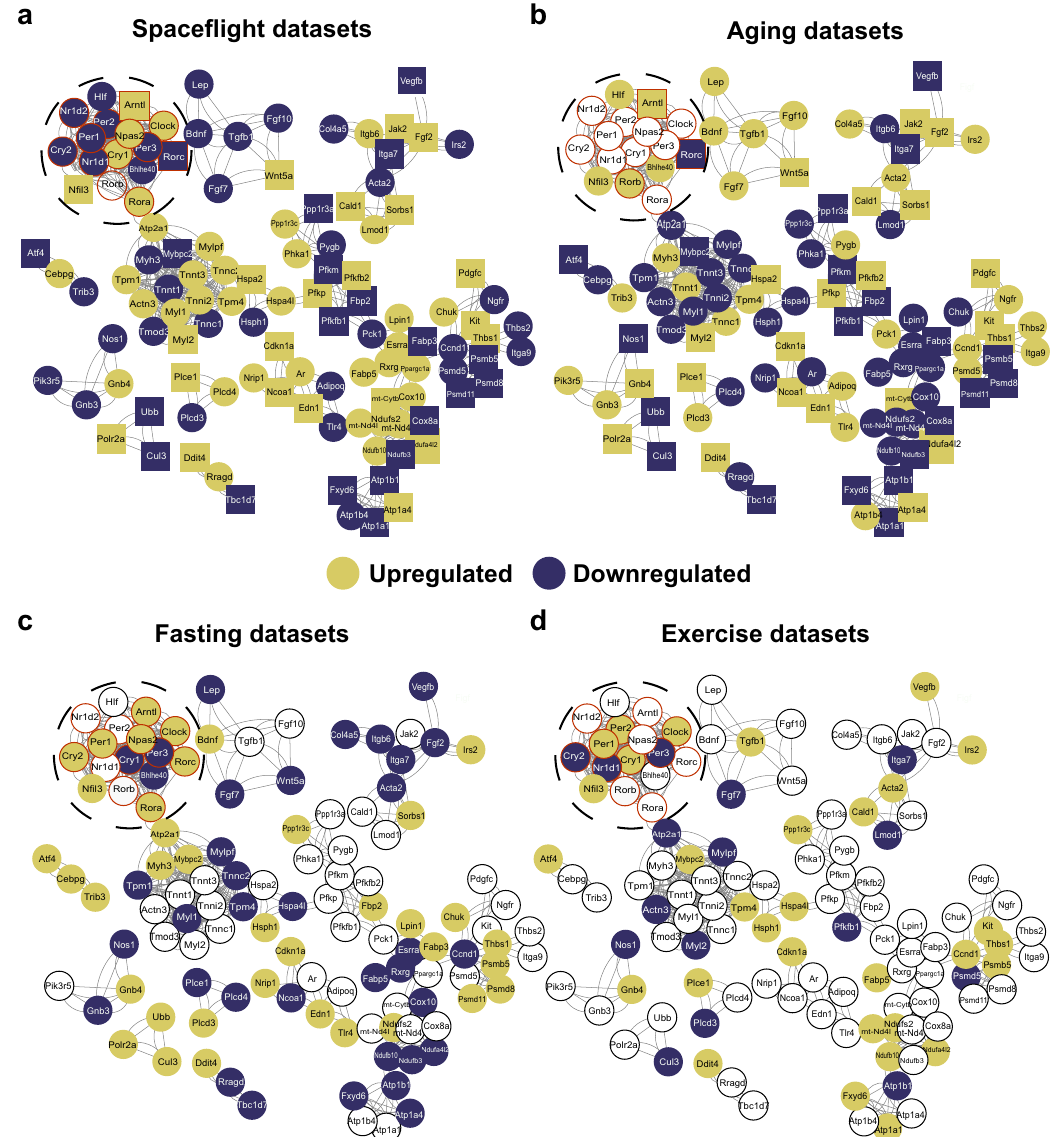
Fig. 7 Network representation of differential expressed genes altered in both space fl ight and aging datasets and their association with core-clock elements. 206 common genes were differentially expressed in at least one of ( a ) the long-term space fl ight datasets (37 days) and ( b ) in extreme age groups (older vs. young). In addition, core-clock elements (bold circles with red border) were also added to the network to explore the regulatory role of circadian clock machinery. Network analysis was carried out using STRING and MCODE, cytoscape based plugins. The same gene sets were plotted for ( c ) fasting and ( d ) exercise datasets. The gene sets were color coded based on their up- or down- regulation compared to their respective controls. Set of genes that depicted similar pattern (up or down-regulation) in space fl ight and aging datasets were shown as rectangles. Genes with no differential expression are represented as white we carried out differential expression analysis between space fl own/aged groups and their respective controls, and used the circadian datasets derived from human and mouse skeletal muscle to visualize possible circadian variations in gene expression. Our analysis showed that the skeletal muscle-associated pathways are clock regulated in both human and mouse datasets, and core- clock alterations can result in similar molecular pattern as seen in space fl ight datasets. For example, skeletal muscle-associated genes like Nfat5 , Fos , and Myod1 showed circadian expression in WT mouse and healthy human datasets while their rhythmicity was changed in clock altered tissues, in a mouse model. Nfat5 showed loss of rhythmicity in both the mouse core-clock altered datasets, and its expression was upregulated in at least one of the space fl ight datasets. Nfat5 is important for myoblast migration